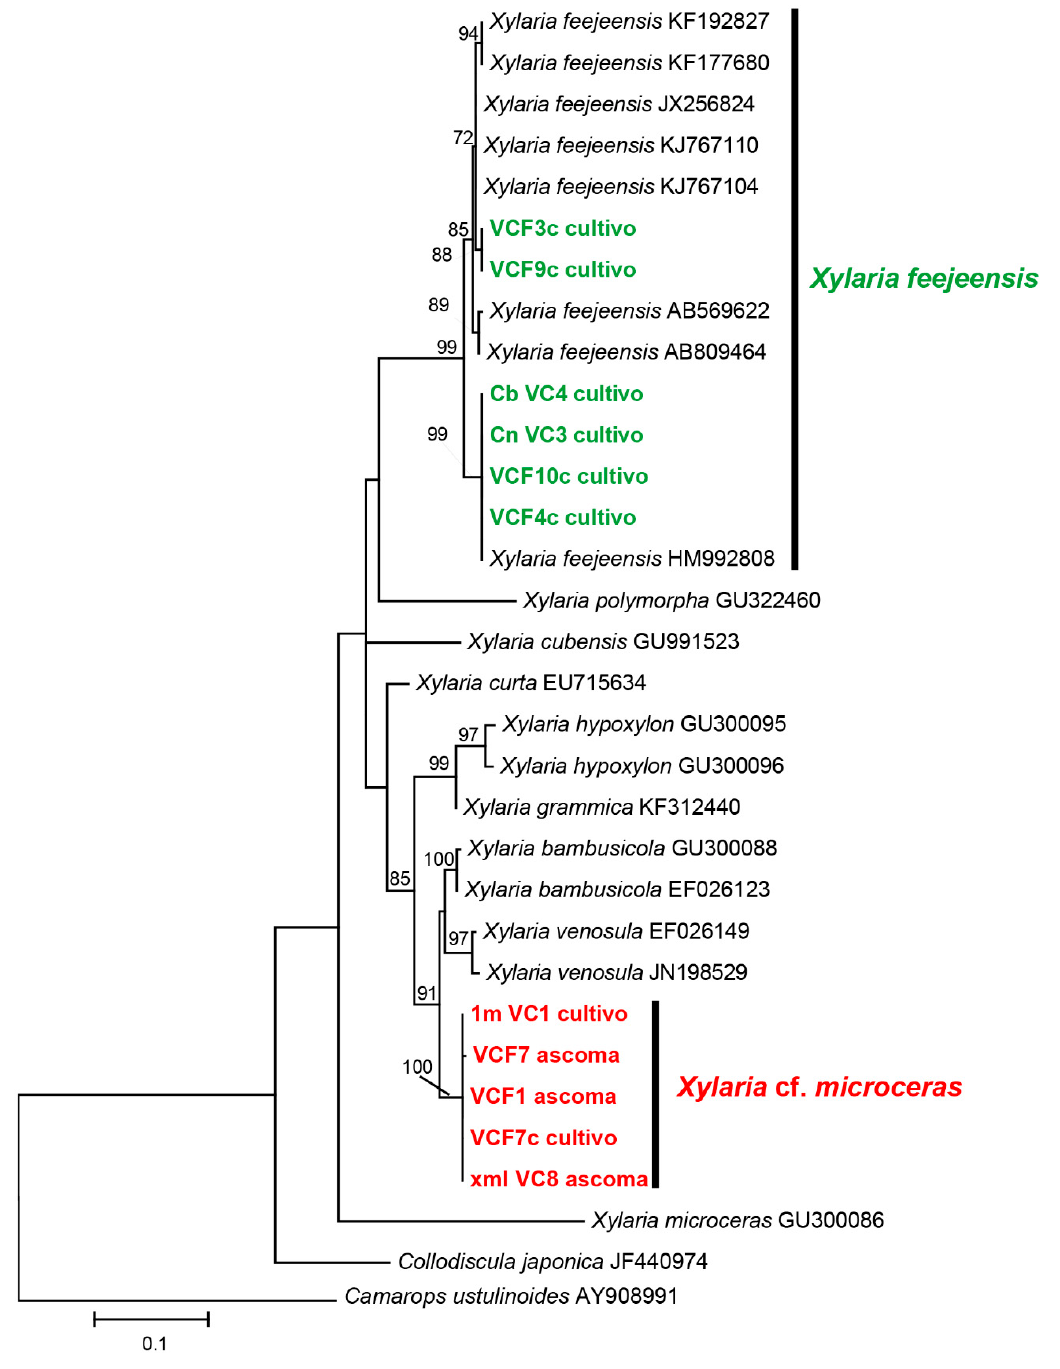
Figure 2. Phylogenetic location of X. feejeensis (green) and X . cf. microceras (red) based on our ITS-5.8S sequences (in bold) and the most related sequences from the GenBank. Only values ≥ 70% are shown on the nodes. The sequence from Camarops ustulinoides with accession number AY908991 was used as out group.